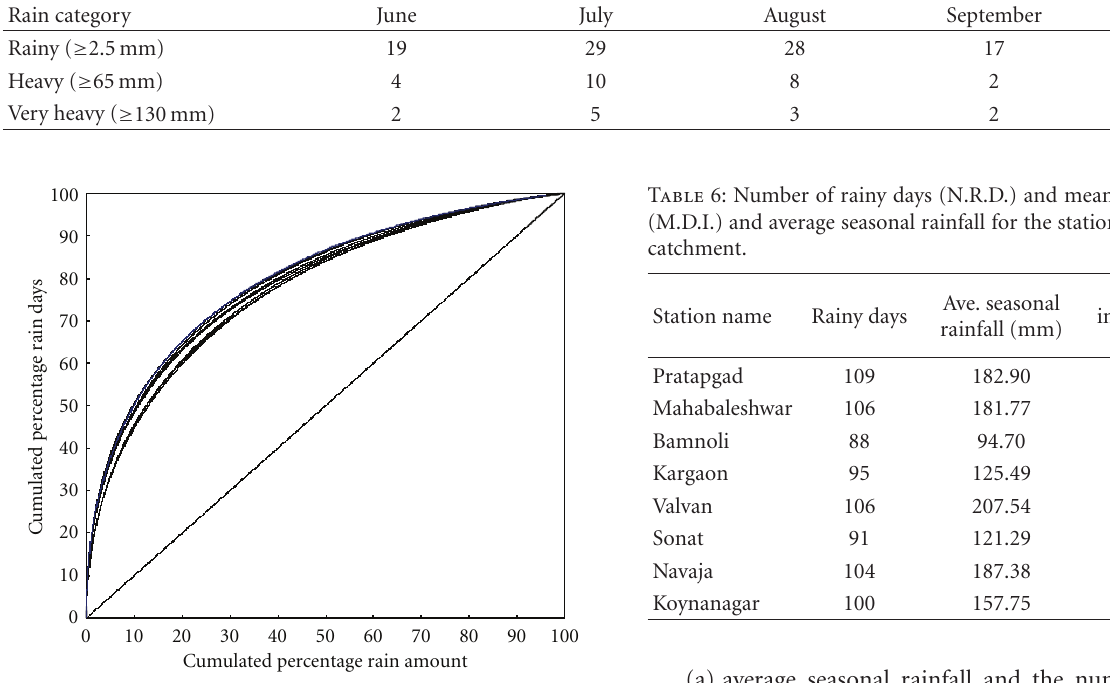
Figure 8: Normalized rainfall curves (NRC) of the stations in the Koyna catchment.